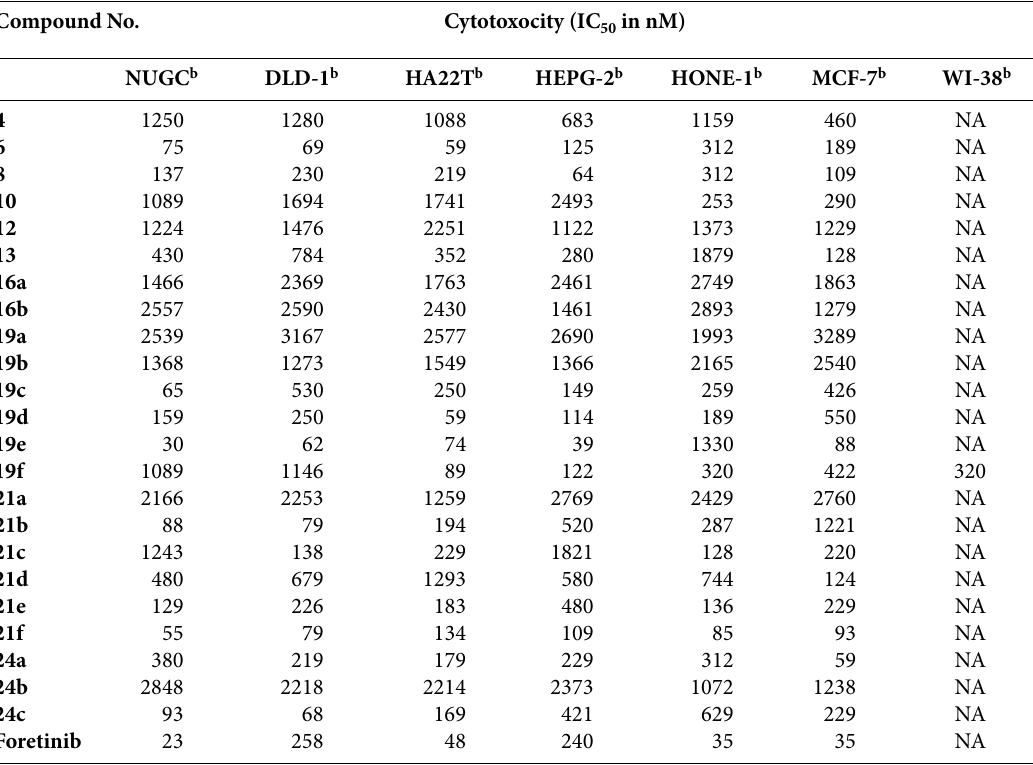
Table 1: Cytotoxicity of the newly synthesized products against a variety of cancer cell lines [IC 50a (nM)] Compound